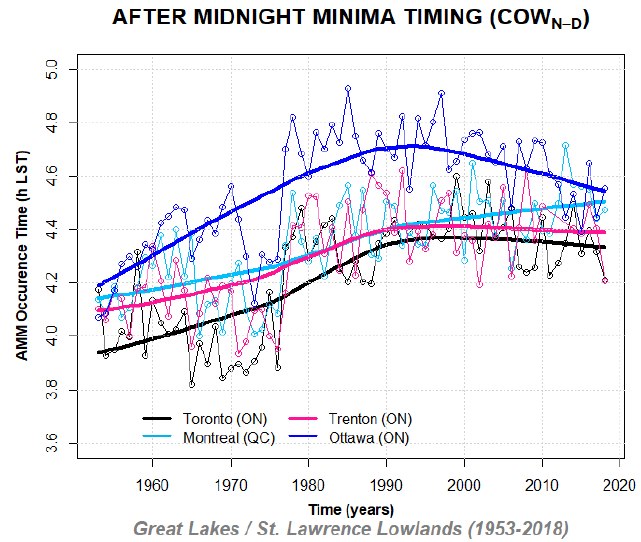
Figure 10. Annually averaged DET AMMt n trends of the Great Lakes/St. Lawrence Lowlands climate region with notable LOESS trends, indicating positive shifts in the After Midnight Minima timing occurrence.